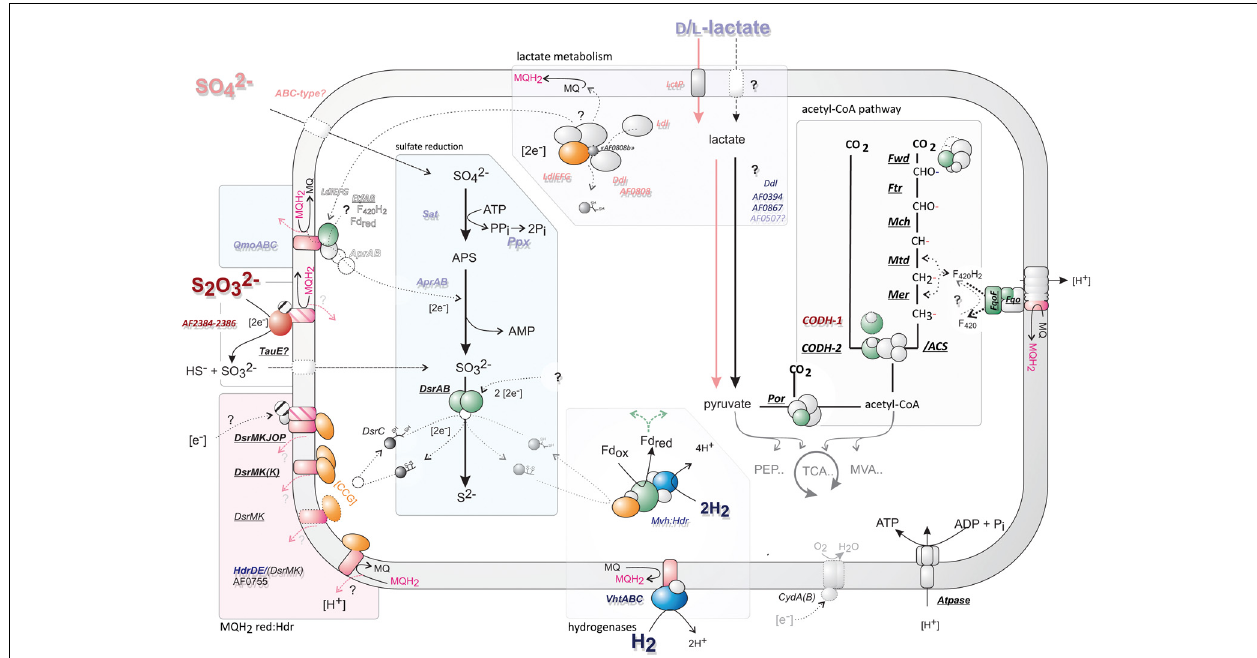
outline of structural features, subunits are colored correspondingly: green—represents potential ferredoxin interacting domains; blue—hydrogenases; magenta—menaquinone/quinol interacting subunits, orange; heterodisulfide reductase (with [CCG] domains). Gene names corresponding to this figure can be found in Table 1 and Table S2—for genes of the acetyl-CoA